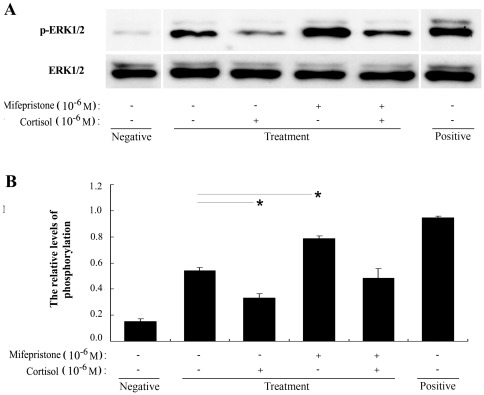
Effects of mifepristone on the ERK signaling pathway in uNK cells.Western blot of p-ERK and total ERK in uNK cells treated with mifepristone ± cortisol. To detect p-ERK and total ERK, total cell lysates were harvested after a 30 min treatment with mifepristone (1.0 µM) ± cortisol (1.0 µM). Uterine NK cells were isolated and cultured in the medium without IL-2 for 12 h as a negative control of MAPK/ERK activation. In the drug treatment groups, uNK cells were cultured in the medium supplemented with IL-2. Uterine NK cells were cultured in the medium with IL-2 and IL-15 for 15 min as a positive control. A typical blot (A) and densitometric scans of triplicate blots (B) are shown. Data were analyzed using ANOVA and expressed as means ± SEM. *, P<0.05.